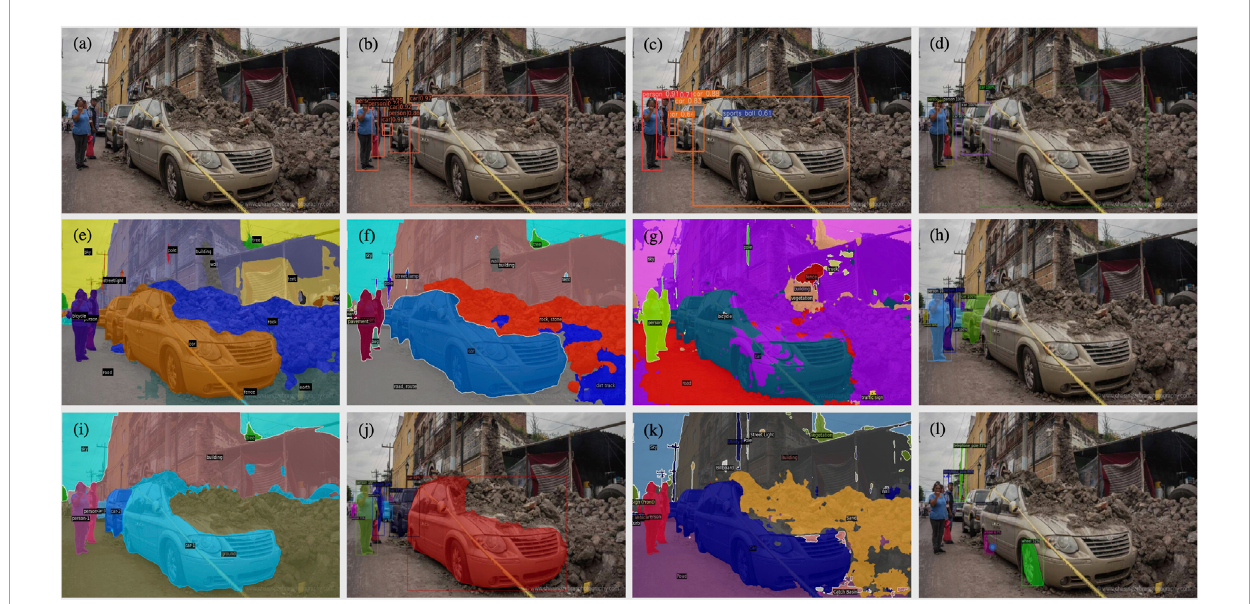
FIGURE 1 (A) Input image; Object Detection: (B) YOLOv5 on COCO, (C) Soft Teacher on COCO, (D) Faster R-CNN on PASCAL-VOC; Semantic Segmentation: (E) BEiT on ADE20K, (F) MaskFormer on ADE20K, (G) MaskFormer on Cityscapes (K) MaskFormer on Mapillary Vistas; Panoptic Segmentation: (I) MaskFormer on ADE20K (J) Panoptic FPN on COCO-Stuff; Instance Segmentation: (H) Mask R-CNN on Cityscapes (L) Mask R-CNN on